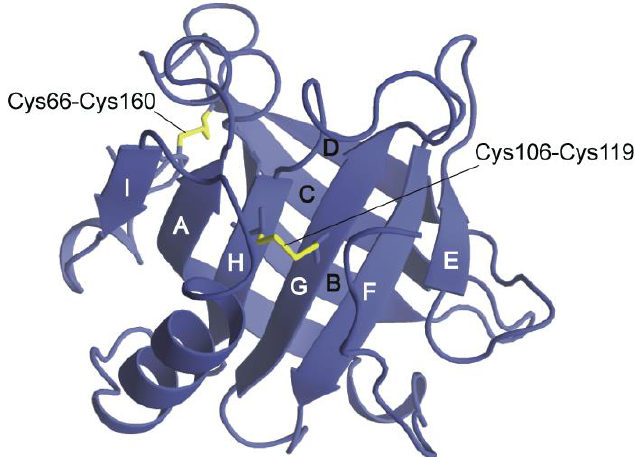
Figure 1. Schematic representation of the three-dimensional structure of  -lactoglobulin. The structure was illustrated on the basis of Protein Data Bank (PDB) coordinates (1BSY [8]) using MolFeat (FiatLux, Tokyo, Japan). Strands are labeled A–I, and disulfide bonds are shown in